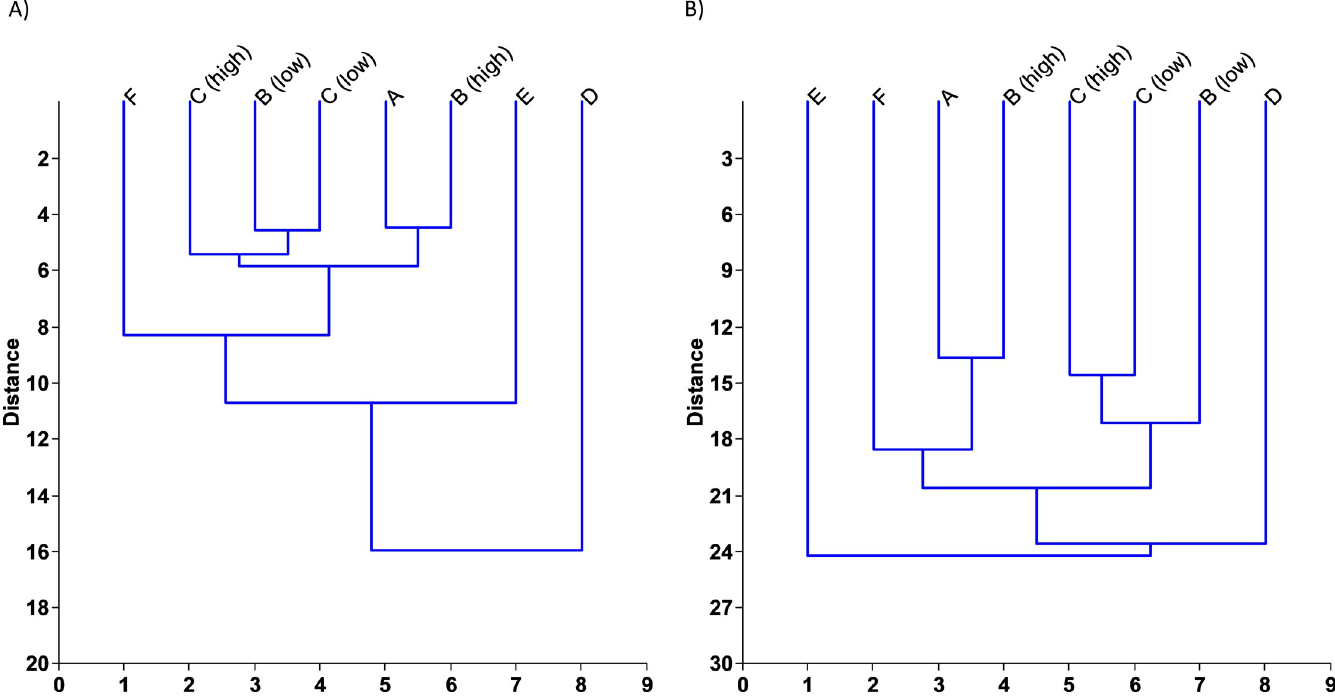
Fig 4. Cluster analysis of the OTUs retrieved in the A) mBRAVE and B) BLAST results. High and low tide sampling events are depicted separately for the respective stations. Stations A-C Elbe estuary, Station D Lake Eichbaum, Stations E and F Lake